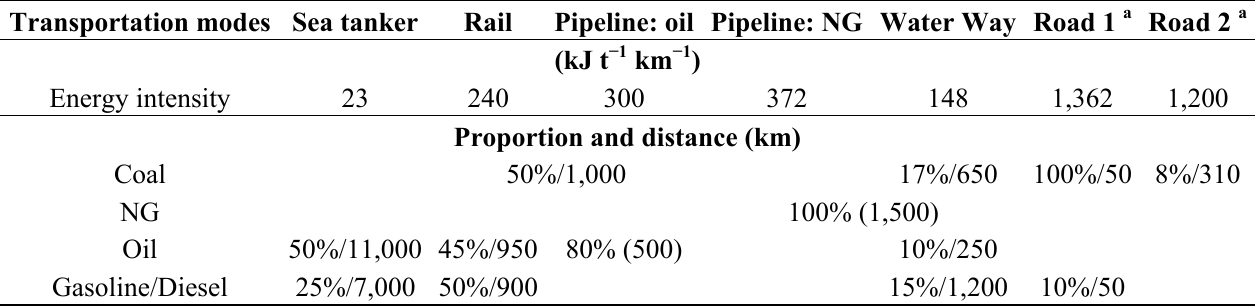
Table 4. Energy intensity, proportion and distance for various modes of transportation [25].